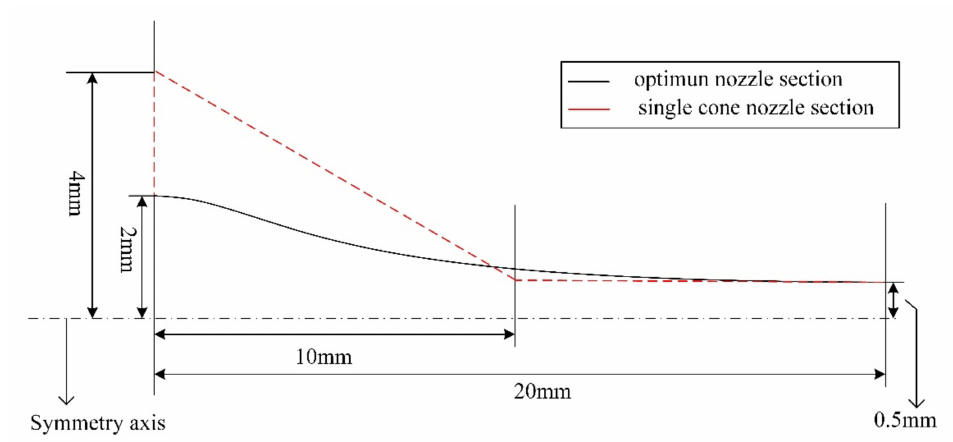
Figure 10. Comparison of the geometry between the optimal and product